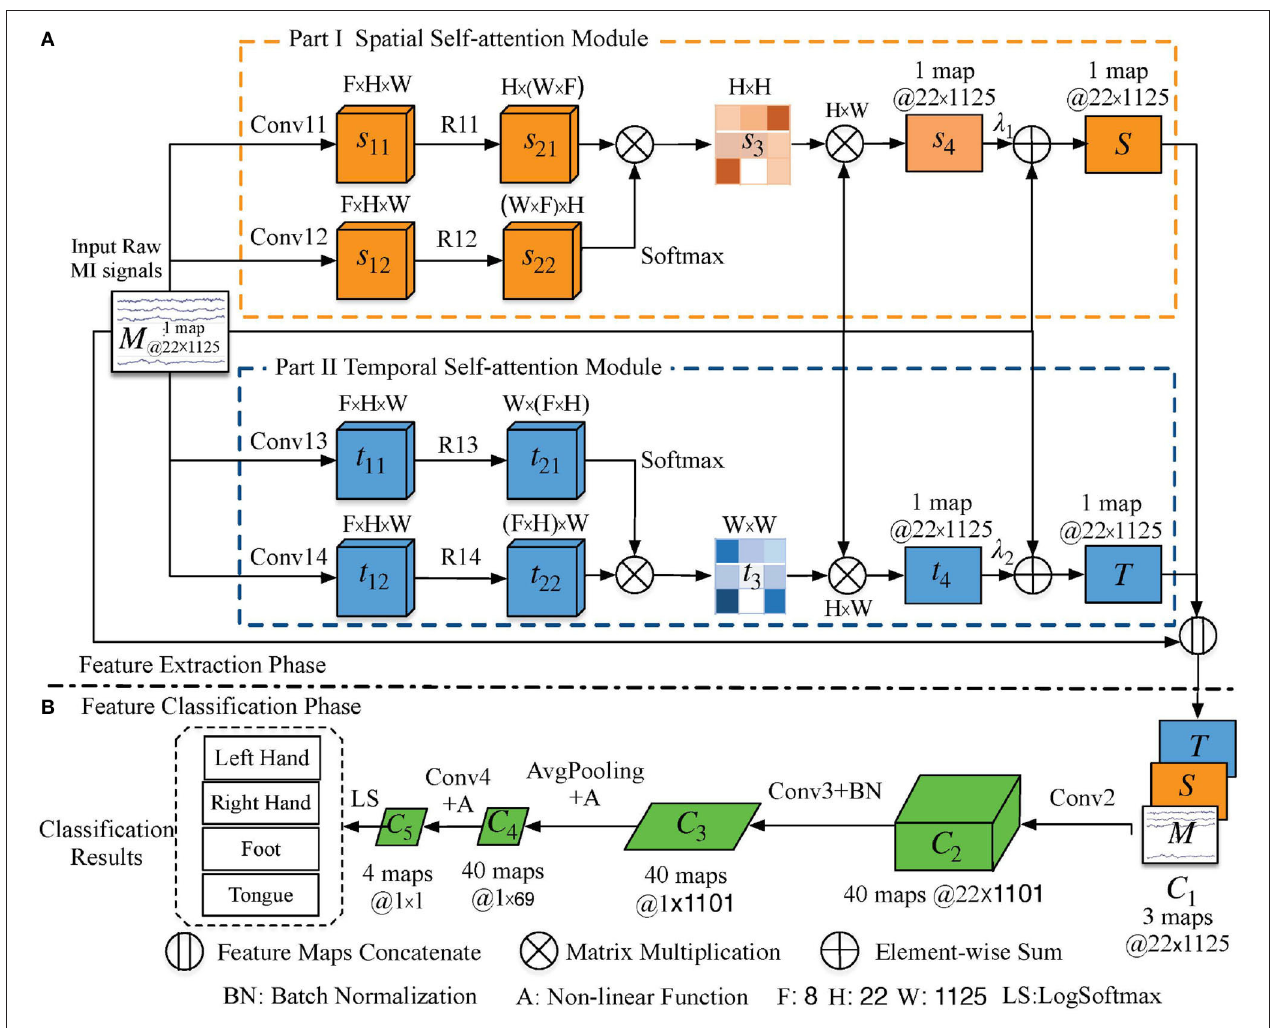
FIGURE 1 | Schematic illustration of the proposed method. The orange, blue, and green cuboids are feature maps in different modules; their corresponding sizes are indicated in the annotation. The convolution and pooling operations are indicated by the arrow lines. (A) Parallel spatial–temporal self-attention architecture-based feature extraction phase. The spatial and temporal self-attention modules are denoted by orange and blue rectangles, respectively. (B) Feature classification phase. F is the number of feature maps, and H and W are the height and width of the input signal, respectively, which means 22 sampling channels with 1,125 time